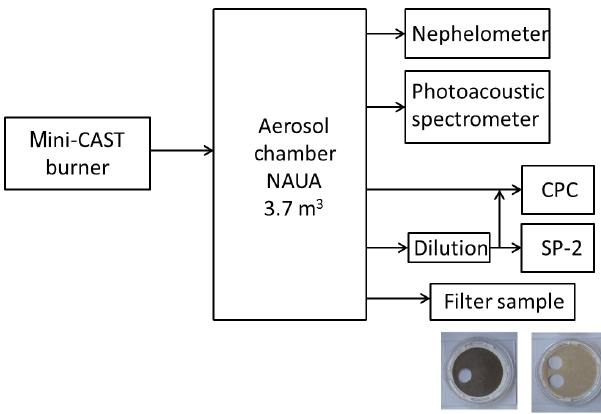
Figure 6. Setup of instruments during the laboratory study SOOT15 and filter samples of CAST soot C / O 0.29 (left) and C / O 0.38 (right). Figure 7. Setup of instruments during field